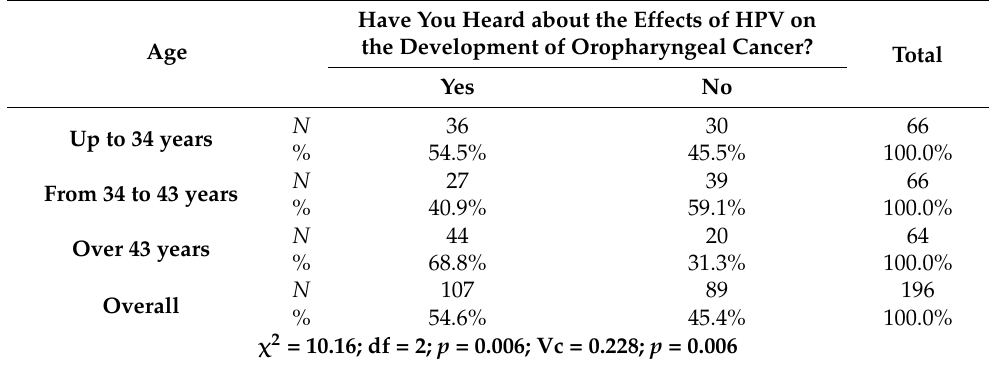
Table 3. Results from analyzing the relationship between the age of the respondents and the awareness of the impact of HPV on the development of oropharyngeal cancer. Have You Heard about the Effects of HPV on the Development of Oropharyngeal Cancer? Total Age Yes No N 36 30 66 Up to 34 years % 54.5% 45.5% 100.0% N 27 39 66 From 34 to 43 years % 40.9% 59.1% 100.0% N 44 20 64 Over 43 years % 68.8% 31.3% 100.0% N 107 89 196 Overall % 54.6% 45.4% 100.0%